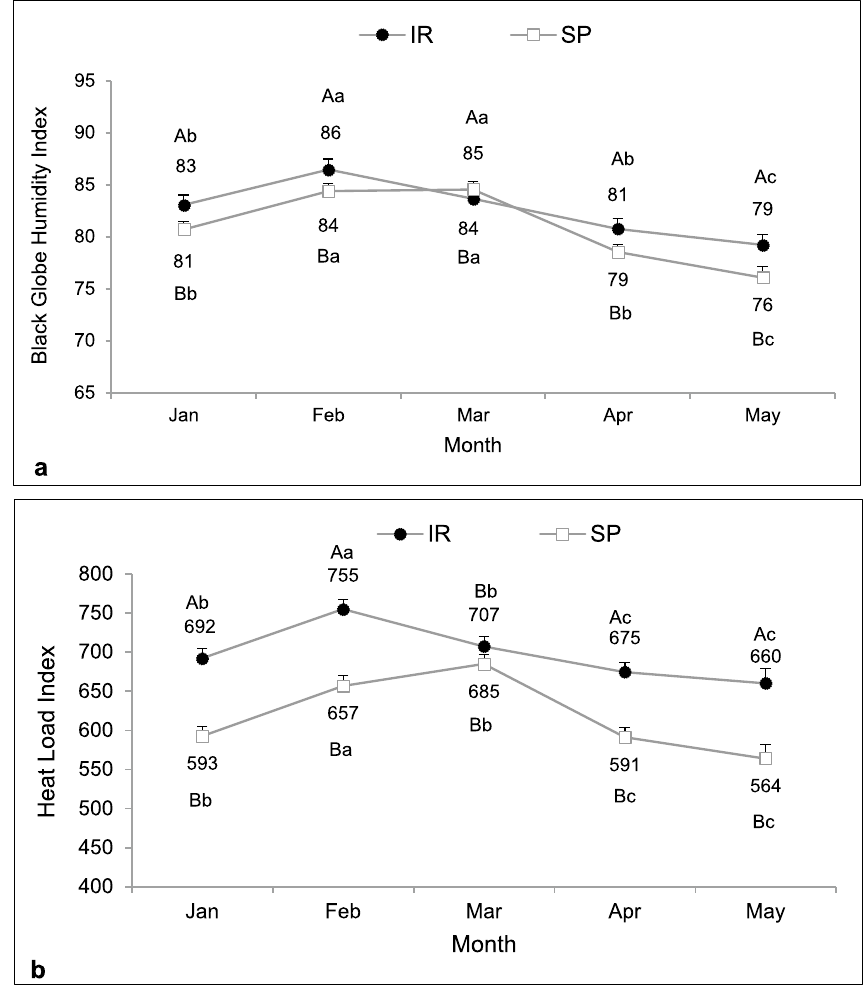
Figure 6. Microclimatic characterization of pasture systems in silvopastoral (SP) or intensive rotational (IR) grazing systems according to black globe humidity index ( a ) and heat load index ( b ) recorded from January to May 2017. Main effects were observed for black globe humidity index, while an interaction was observed for heat load index. A,B Different capital letters indicate a significant difference between systems. a,b,c Different lowercase letters indicate a significant difference between